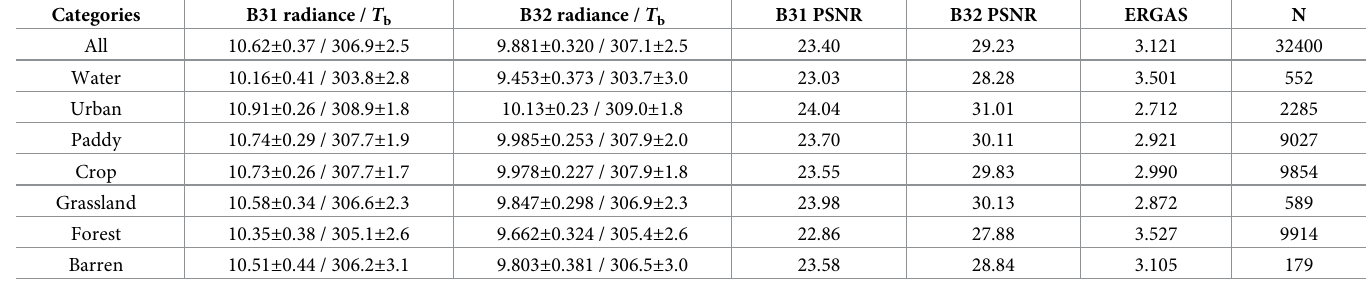
Table 4. Statistics for super-resolved thermal data and accuracy indices for Algorithm 3 for each land-cover type. The land-cover type was determined using previ- ously reported data [34], while unclassified and snow/ice categories were excluded. Note that the four forest categories (see Fig 4) were integrated into the one category. Radiance (W/m 2 /str/ μ m) with standard deviation, T b (brightness temperature; K) with standard deviation, PSNR, ERGAS, and N (number of sample pixels) are listed. Categories